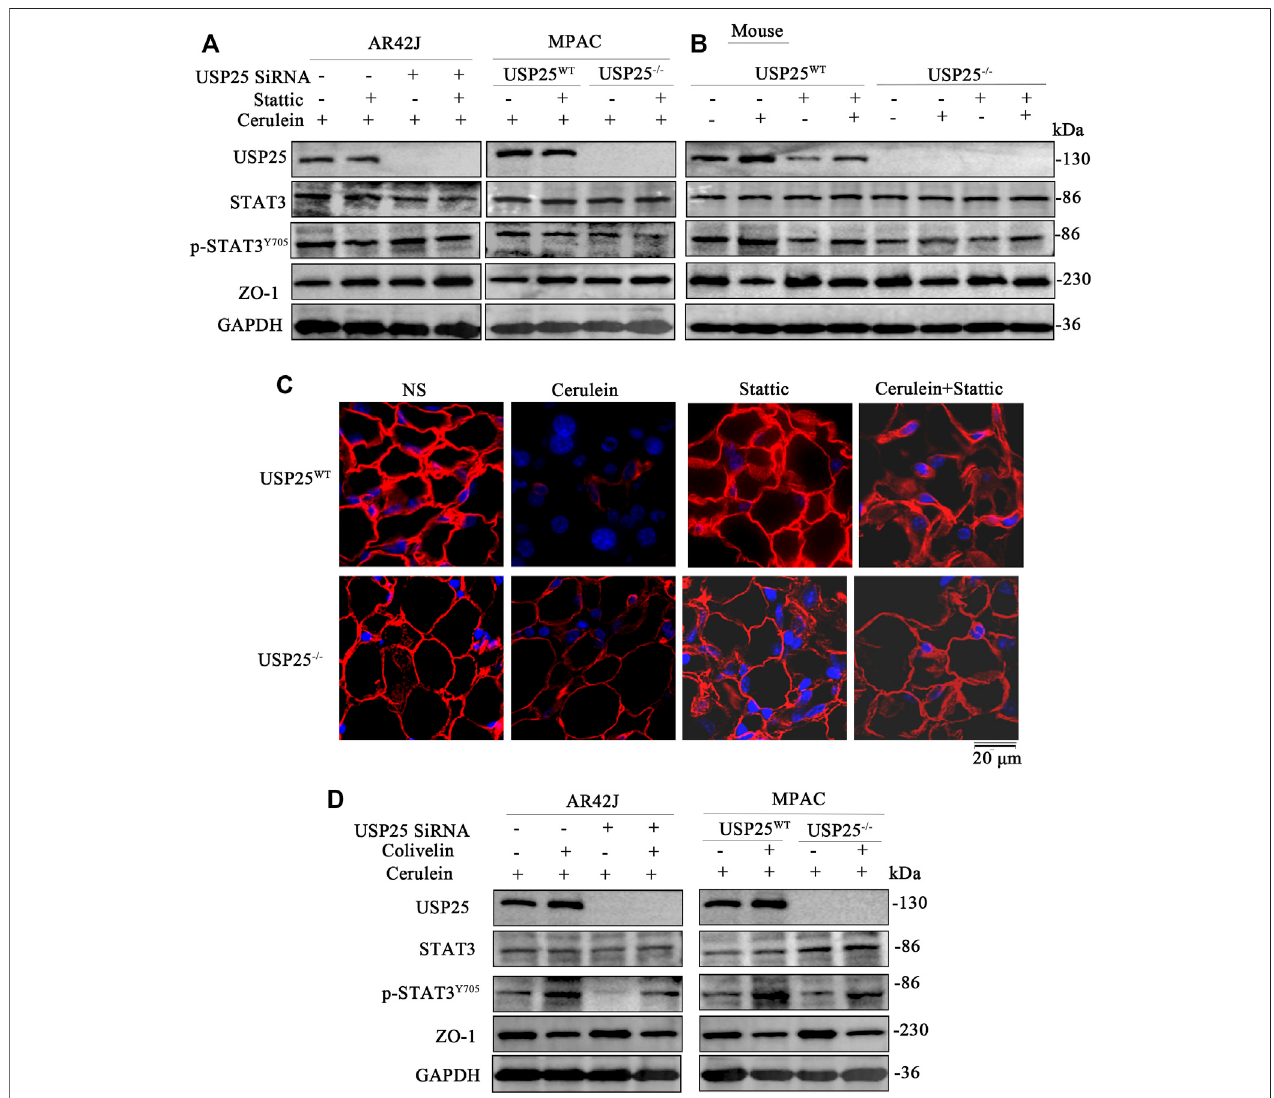
FIGURE 8 | USP25 aggravates acute pancreatitis and acute pancreatitis-related multiple organ injury by destroying tight junctions through activating STAT3 pathway invitro and invivo .StatticwasusedtointerferewithSTAT3phosphorylationinAR42J,MPACcellsandmice(n (cid:1) 8pergroup),thenceruleinwasusedtoinduce AP. Colivelin (STAT3 agonist) was used to activate STAT3 in AR42J and MPAC cells, and then cerulein was used to induce AP in cells (A – B) Western blotting was performed to measure the protein levels of USP25, STAT3, p-STAT3 Y705 , and ZO-1 in AR42J, MPAC cells and mice pancreases after stattic treatment. (C) Immuno fl uorescence was performed to measure the protein level of ZO-1 in mice pancreases of eight groups. (D) Western blotting was performed to measure the protein levels of USP25, STAT3, p-STAT3 Y705 , and ZO-1 in AR42J, MPAC cells after colivelin treatmenet.